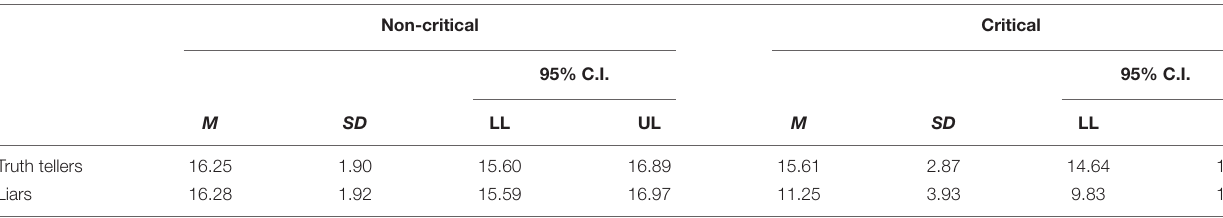
TABLE 4 | Means, standard deviations, and 95% confidence intervals of simple effects analyses for truth tellers and